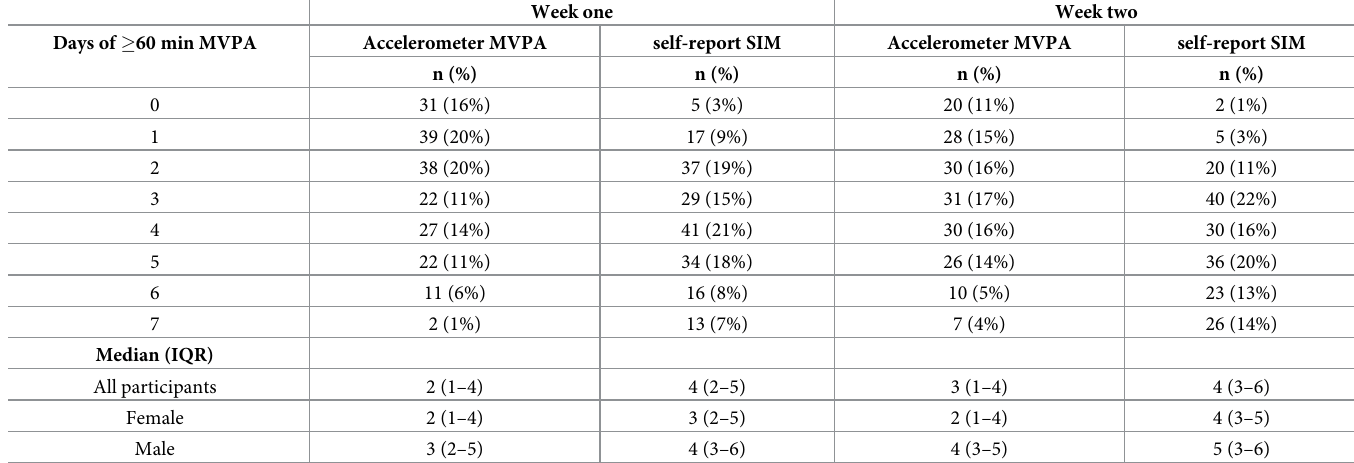
Table 2. Frequency of days with � 60 minutes of moderate-to-vigorous intensity physical activity (MVPA) at a single time point as measured using accelerometry and single item measure (SIM)